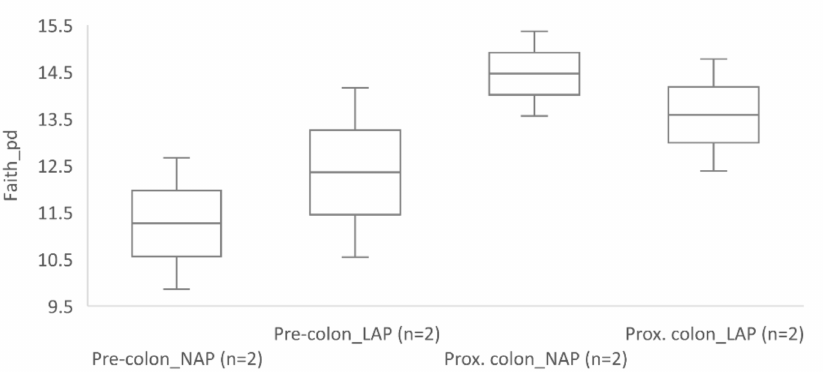
Figure 2. Faith’s phylogenetic diversity observed in the pre-colon and proximal colon bioreactors of baby-SPIME when using AP (LAP) or not (NAP) for two donor piglets.